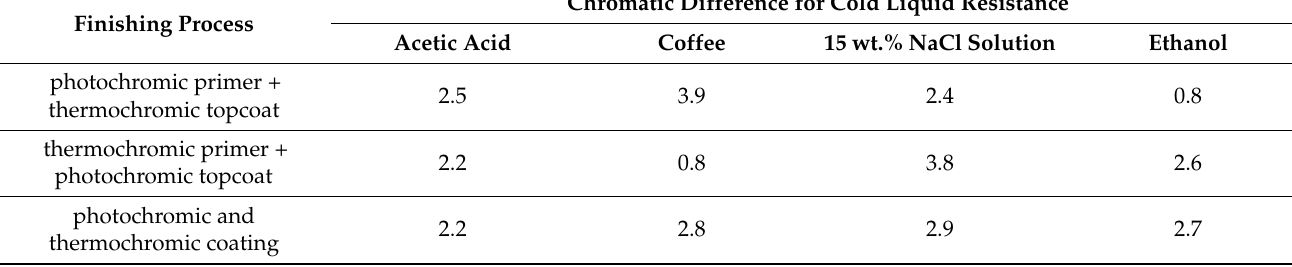
Table 6. The chromatic difference of the film before and after cold liquid resistance tests under different finishing